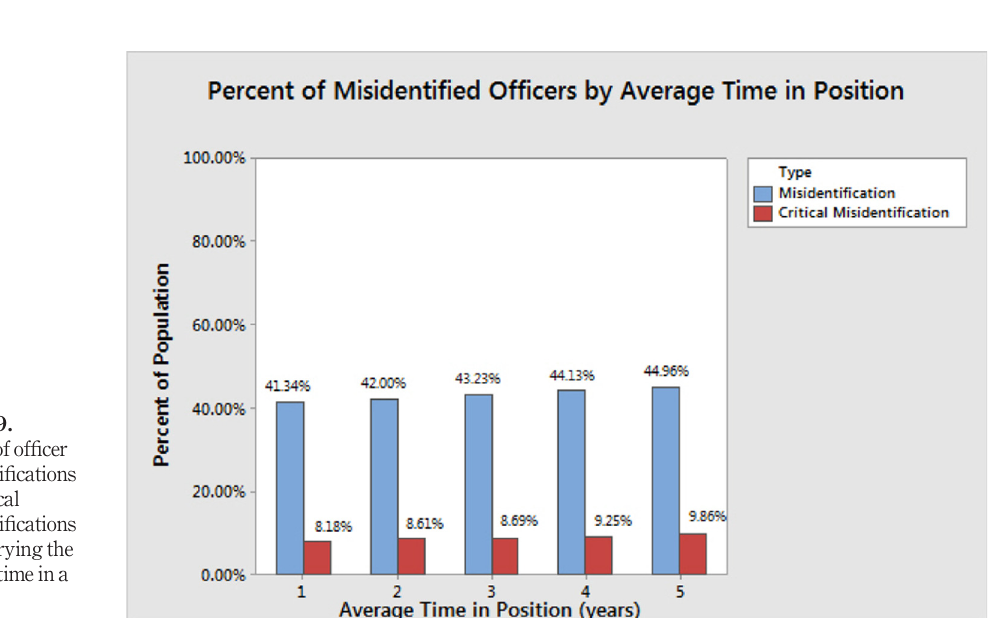
Figure 8. Effect of changing the average time in position on the performance appraisal system accuracy